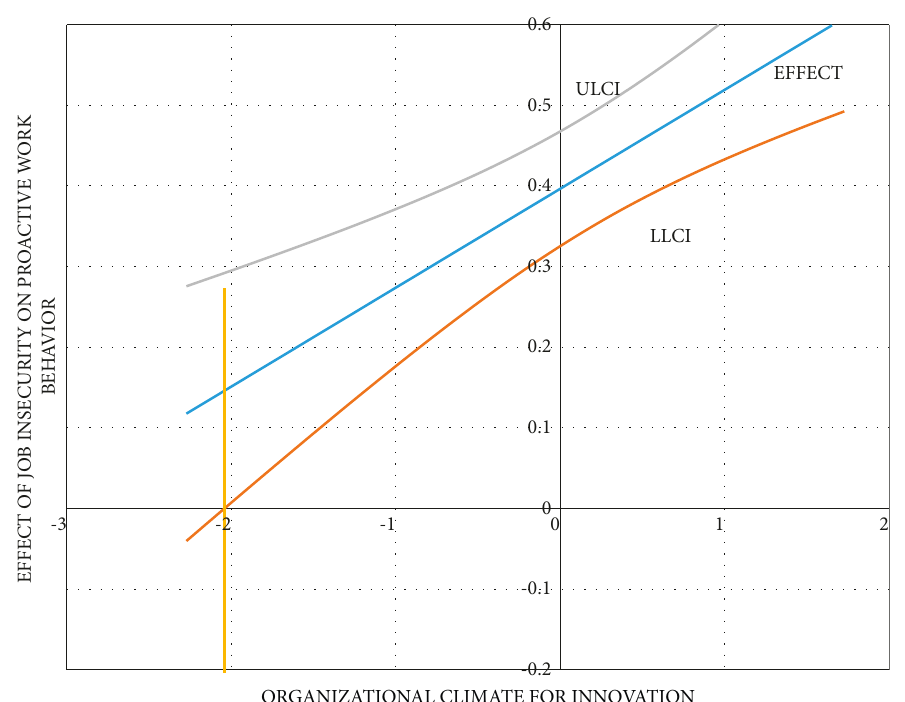
Figure 2: Effect of organizational climate for innovation on job insecurity and proactive work